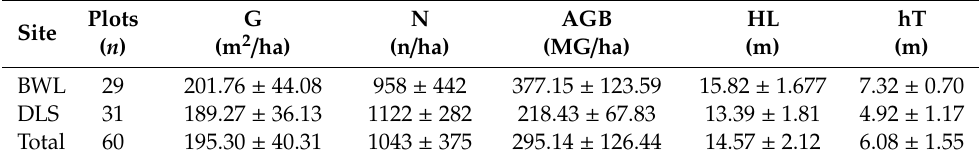
Table 2. Forest structural parameters of the canopy tree descriptions of the study sites and sample plots.